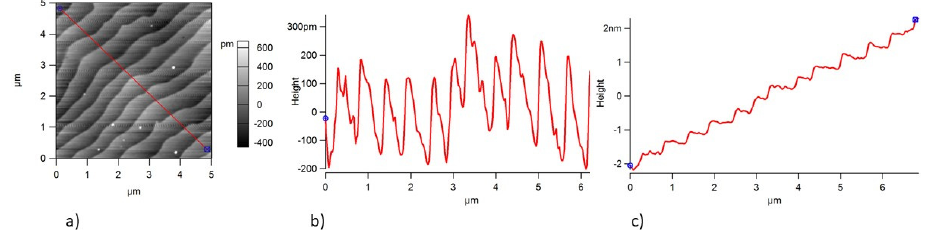
Figure 2. The surface topography of STO substrate after thermal and chemical treatment ( a ) with line profile ( b ) by AFM. The line profile after processing the image by plane leveling procedure ( c ).